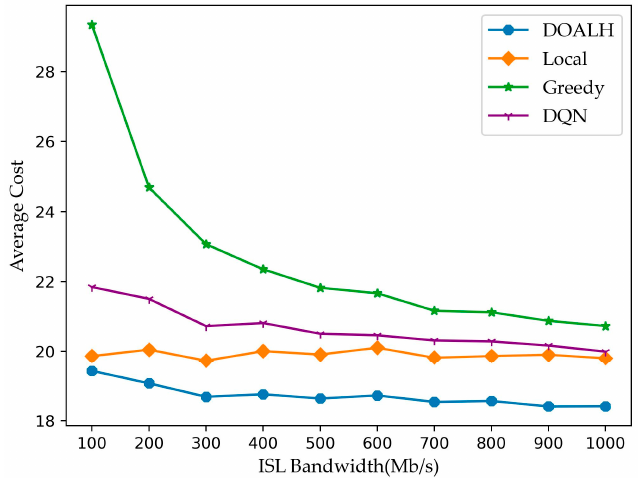
= 50, β = 0.1, V = 10 Average Cost vs. ISL Figure 7. 𝑀 = 50, 𝛽 = 0.1, 𝑉 = 10 Average 𝐶𝑜𝑠𝑡 vs. ISL bandwidth. Figure 7. M Figure 7. 𝑀 = 50, 𝛽 = 0.1, 𝑉 = 10 Average 𝐶𝑜𝑠𝑡 vs. ISL bandwidth.